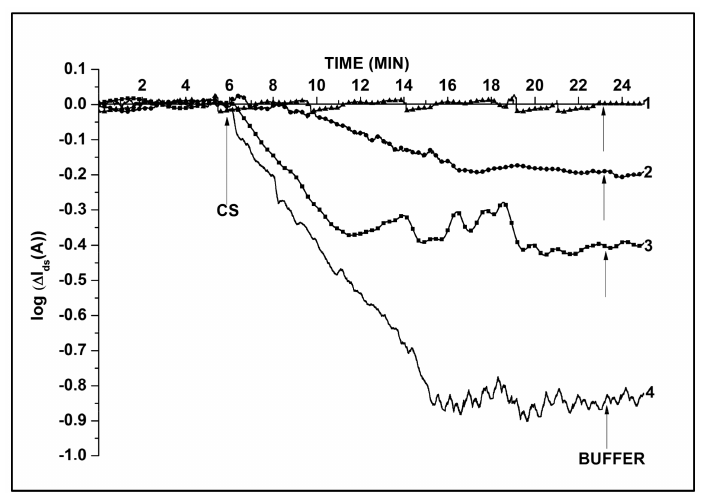
Figure 5. Typical ∆ I ds ( t ) dependencies obtained upon detection of oDNA in buffer using (h-k)-SOI-NW sensors with immobilized oDNA probes. Experimental conditions: 1 mM potassium phosphate buffer (pH 7.4), V g = − 50 V, V d = − 0.2) V, total volume of solution in the cell 450 µ L. Final concentrations of target oDNA in the measuring cell were 3.3 × 10 − 17 M (curve 1), 3.3 × 10 − 16 M (curve 2), 3.3 × 10 − 15 M (curve 3), 3.3 × 10 − 14 M (curve 4). Arrows indicate the addition of target oDNA solution (CS) and wash with